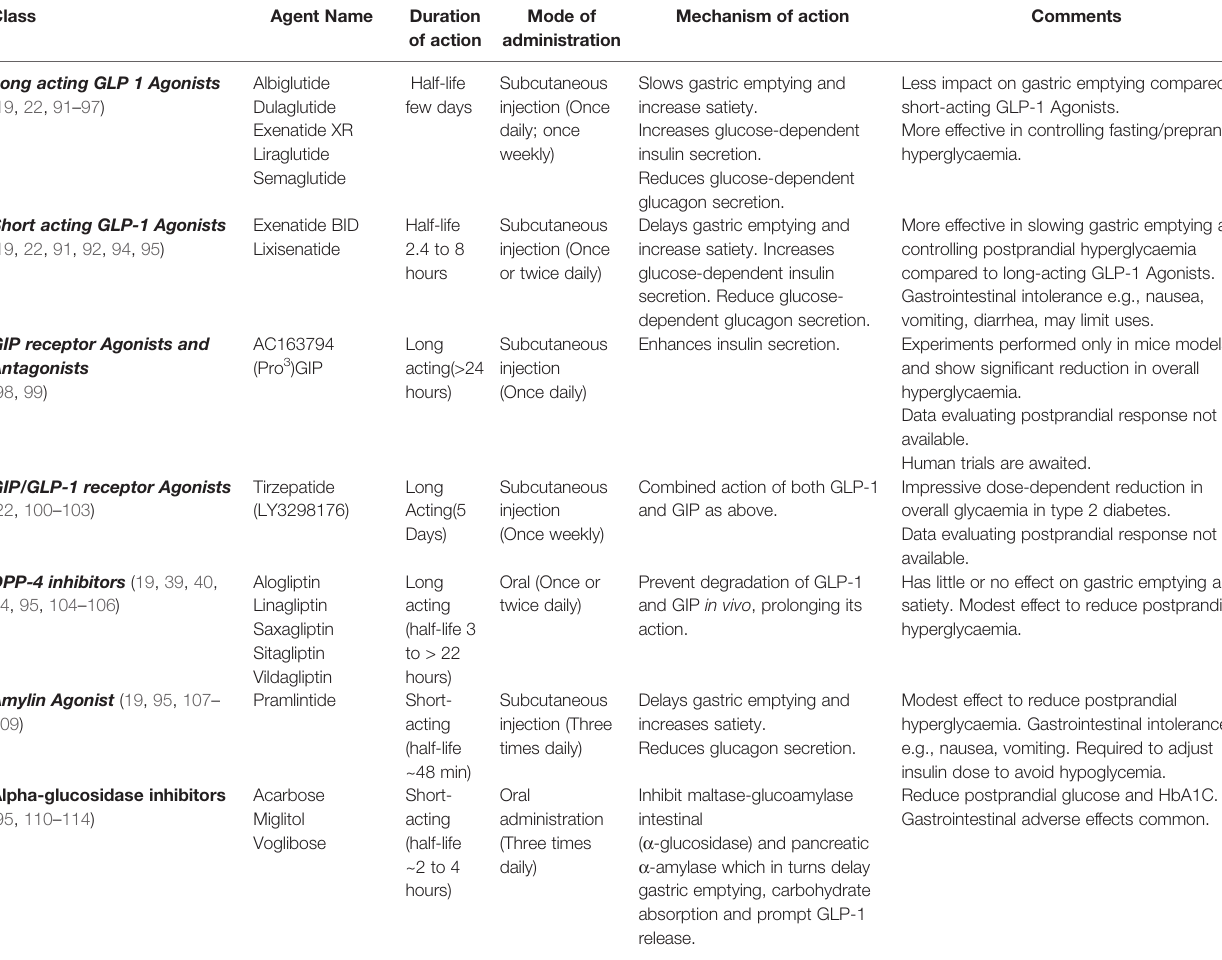
TABLE 2 | Summary of the pharmacological agents targeting postprandial